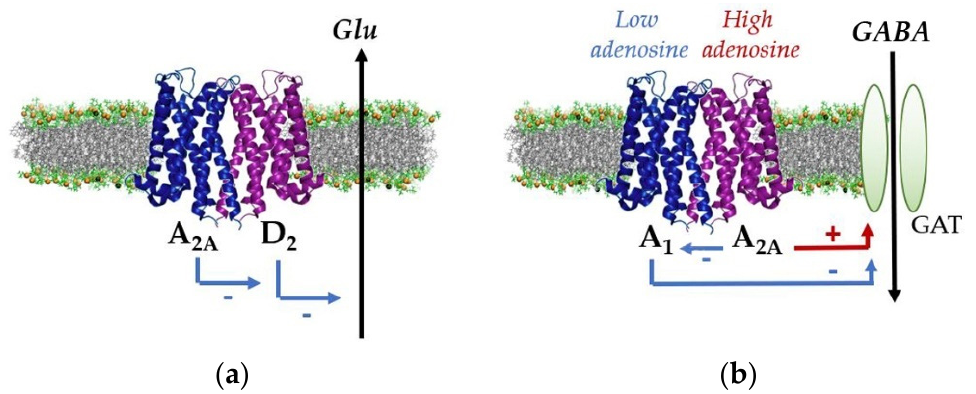
Figure 2. Schematic view of signaling processes driven by receptor complexes in astrocytes: ( a ) Mod- ulation of the release of glutamate by the A 2A –D 2 receptor complex [81]. Dopamine D 2 receptor activation inhibits the release of glutamate, while activation of adenosine A 2A receptors abolishes the effect of D 2 activation; ( b ) Control of GABA uptake through GABA transporters (GAT) by the adenosine A 1 –A 2A receptor complex [87] (see text).